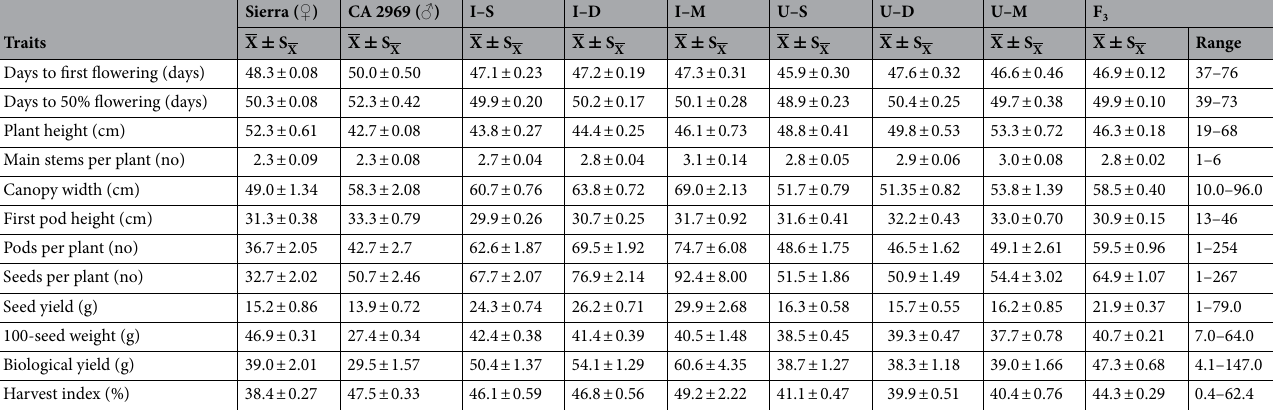
Table 1. Means ± standard errors and range for agro-morphological traits in F 3 population derived from intraspecific crosses between Sierra (single-podded and unifoliolate-leafed) and CA 2969 (double-podded and imparipinnate-leafed). I–S: imparipinnate-leafed and single-podded progeny, I–D: imparipinnate-leafed and double-podded progeny, I–M: imparipinnate-leafed and multi-podded progeny, U–S: unifoliolate-leafed and single-podded progeny, U–D: unifoliolate-leafed and double-podded progeny, U–M: unifoliolate-leafed and multi-podded progeny.